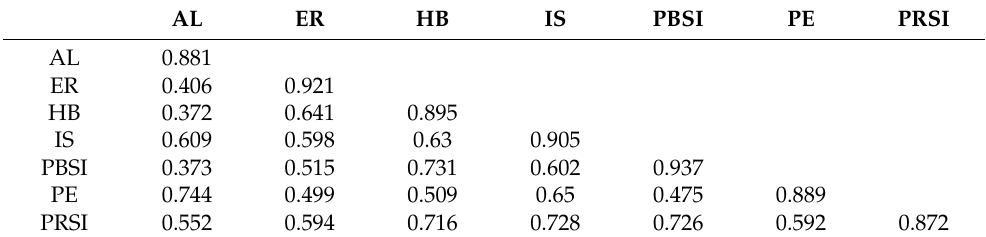
Table 4. Fornell-Larcker Criteria for the Reassurance Group.